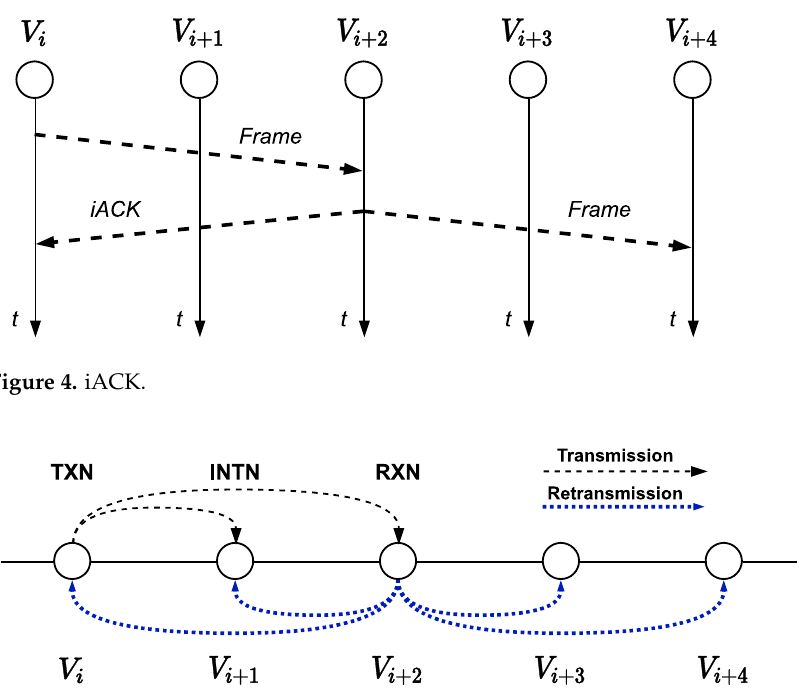
Figure 5. Node v i transmits to node v i+ 2 .